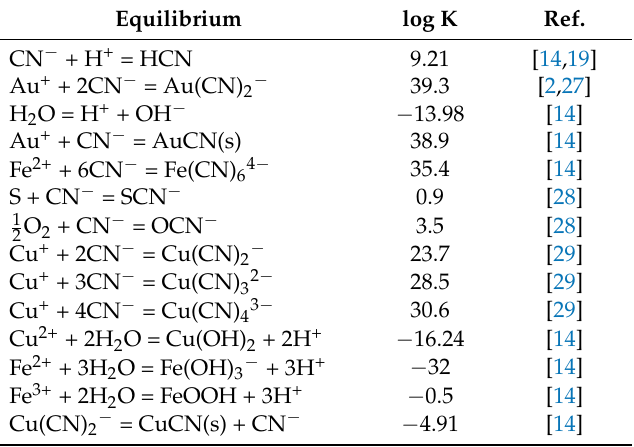
Table 1. Main equilibria of the Cu-CN-Fe-Au-S-O-H system (25 ◦ C, 1 atm and I =